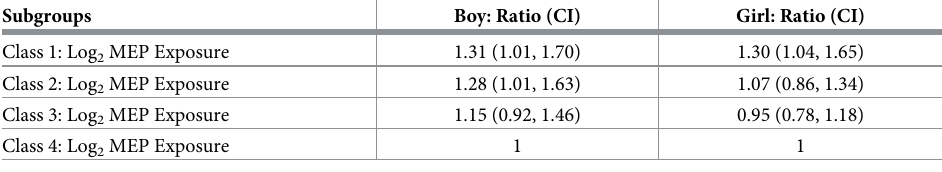
Table 1. Estimated ratios comparing class probabilities to the probability of Class 4 for a doubling of MEP and associated 90% confidence interval from estimated four-group growth mixture model fit to the CHAMACOS data, boys and girls separately.